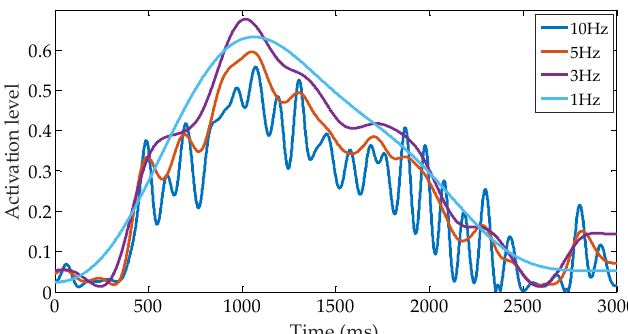
Figure 17. Muscle activations calculated with different low-pass cutoff frequencies. Results with 10, 5, 3 and 1 Hz are plotted to make the graph easy to read.